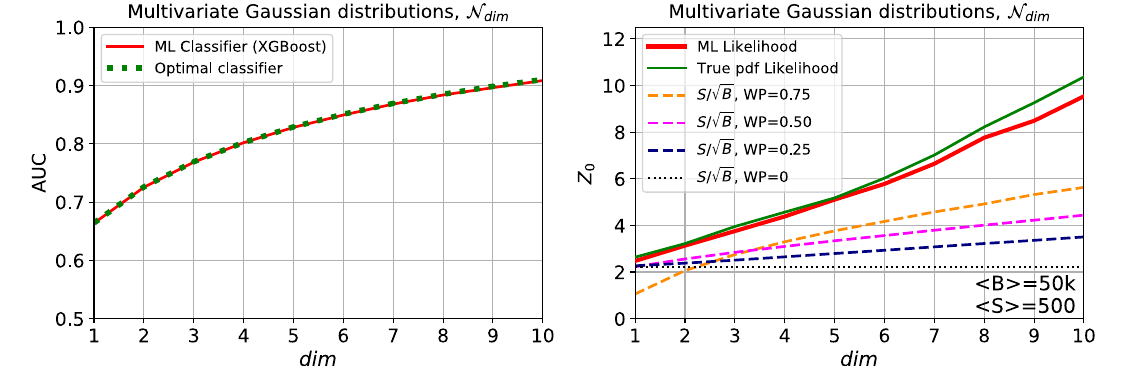
Fig. 6 Left panel: AUC for the binary classifier using XGBoost (red curve) and the optimal classifier calculated with Eq. (9) (green dot- ted curve) as a function of the data dimension, dim , for multivariate Gaussian variables. Right panel: significance calculated with various methods as a function of dim . For every case, the background and signal strengths were fixed, (cid:8) B (cid:9) = 50k and (cid:8) S (cid:9) = 500. Solid lines show the results implementing the method described in this work with: XGBoost used to estimate the probability density for single events